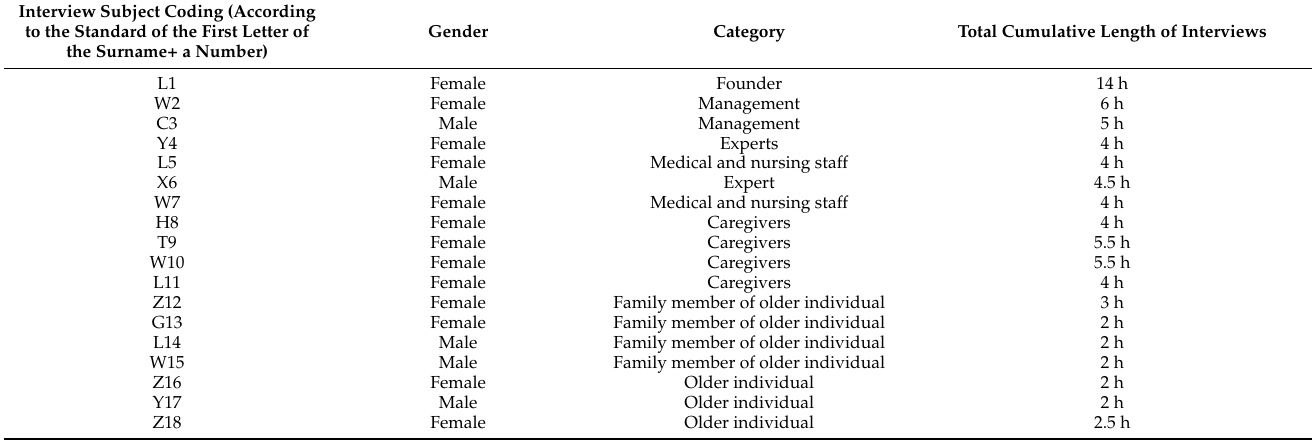
Table 2. Profile of